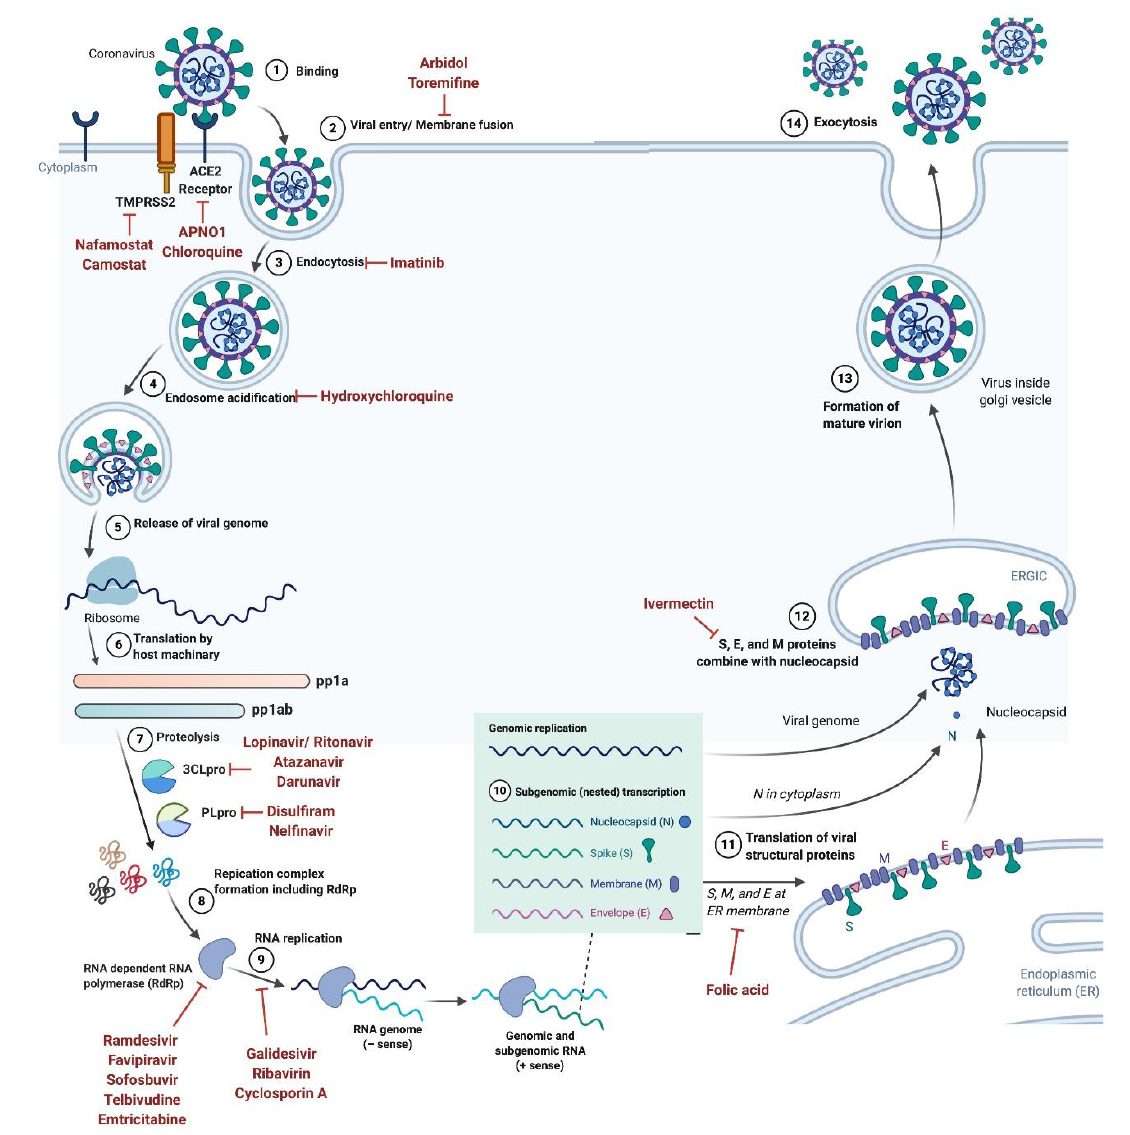
Figure 2. Schematic representation of SARS-CoV-2 virus life cycle. Drugs targeting different steps of coronavirus entry and lifecycle in human cells are also shown.